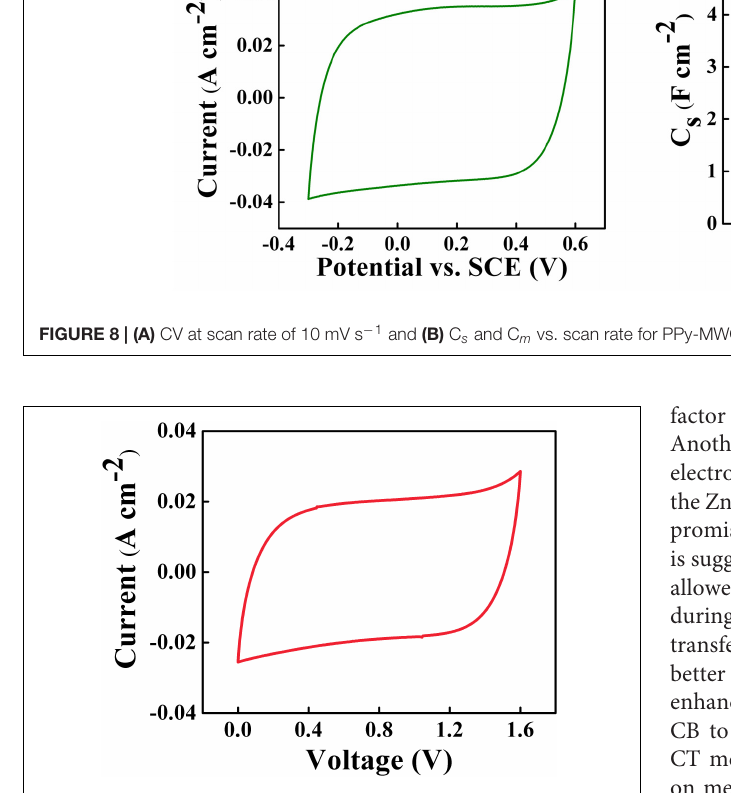
FIGURE 9 | CV at scan rate of 10 mV s − 1 of asymmetric supercapacitor cell containing Zn-Fe-DH -MWCNT negative electrode and PPy-MWCNT positive electrode.